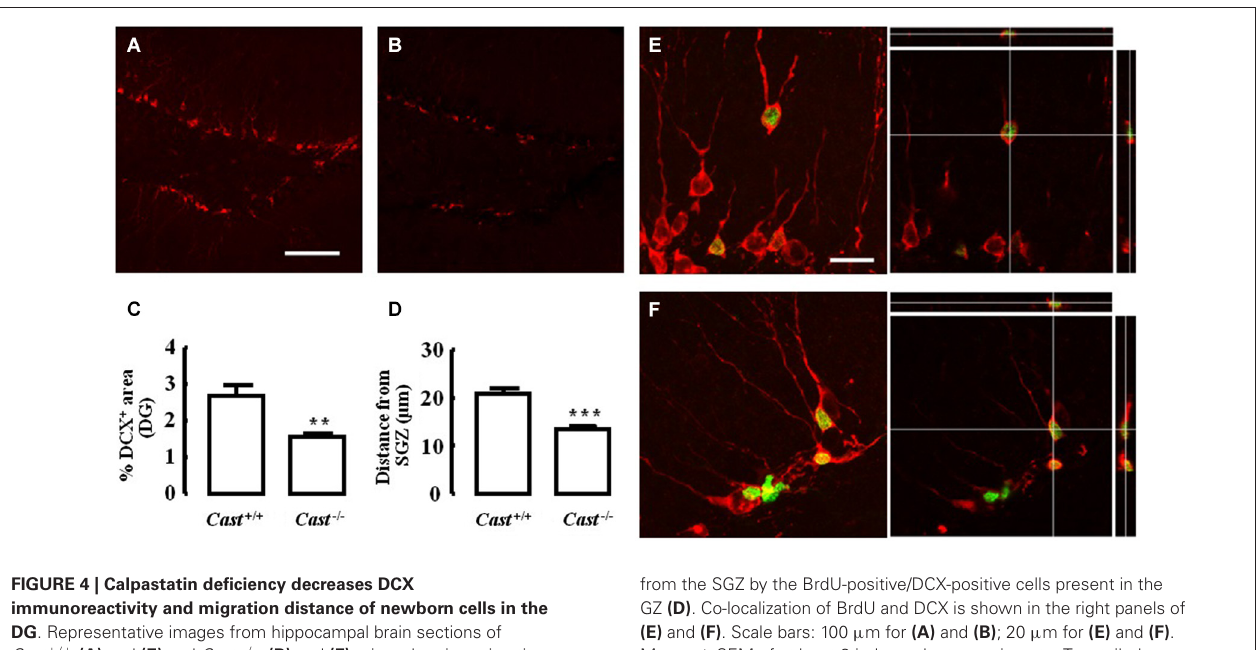
FIGURE 4 | Calpastatin deficiency decreases DCX immunoreactivity and migration distance of newborn cells in the DG . Representative images from hippocampal brain sections of Cast + / + (A) and (E) and Cast − / − (B) and (F) mice, showing migrating neuroblasts in red, labeled for DCX, and BrdU-positive cells in green. Percentage of DCX immunoreactivity in the DG (C) . Distance migrated